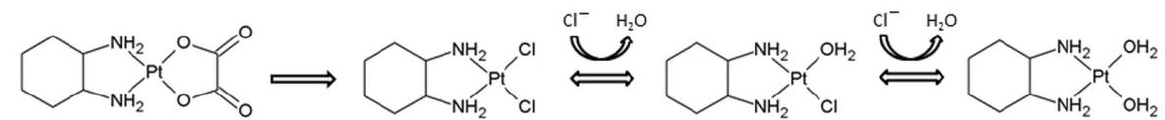
Figure 2. Pathway of Oxaliplatin and anticancer activity.